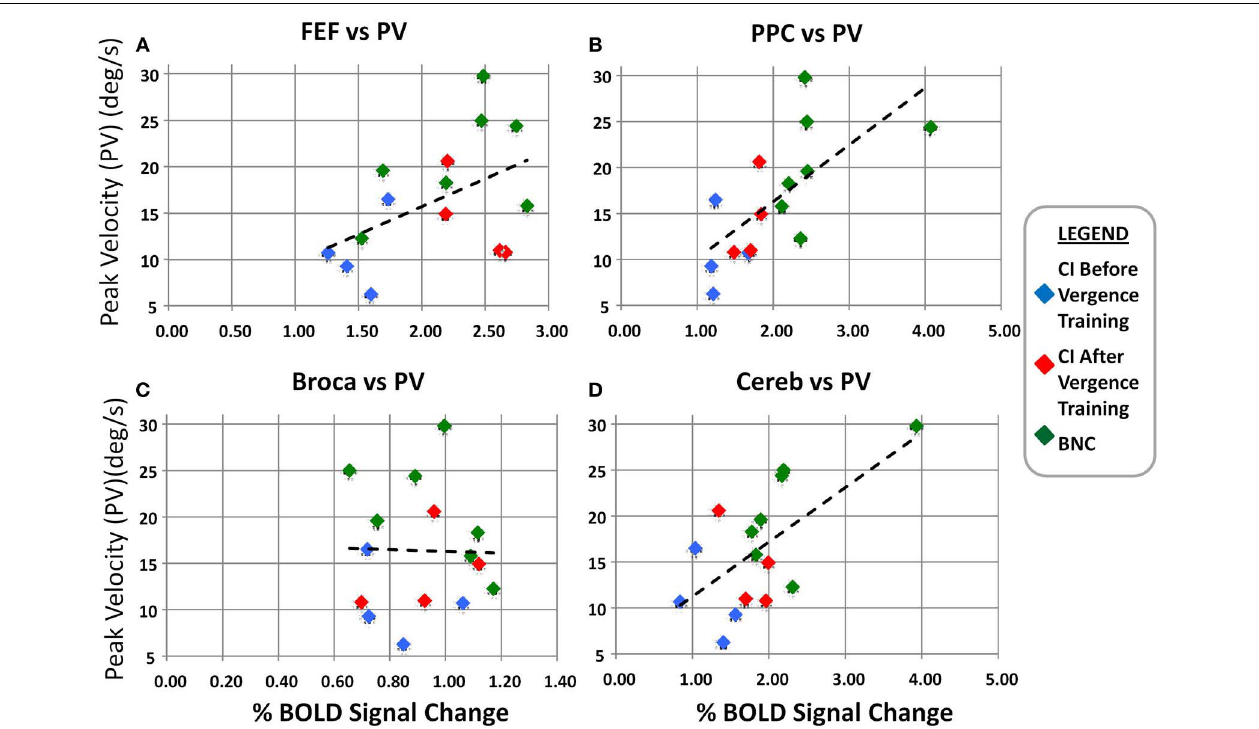
FIGURE 6 | Linear regression analysis of the convergence peak velocity ( ◦ /s) as a function of the percent BOLD signal change for the FEF (A), PPC (B), Broca’s region (C), and Cerebellar Vermis (D). The left and right percent BOLD signal changes were averaged. The blue diamonds are from the CI subjects before vergence training, the red diamonds are the same CI